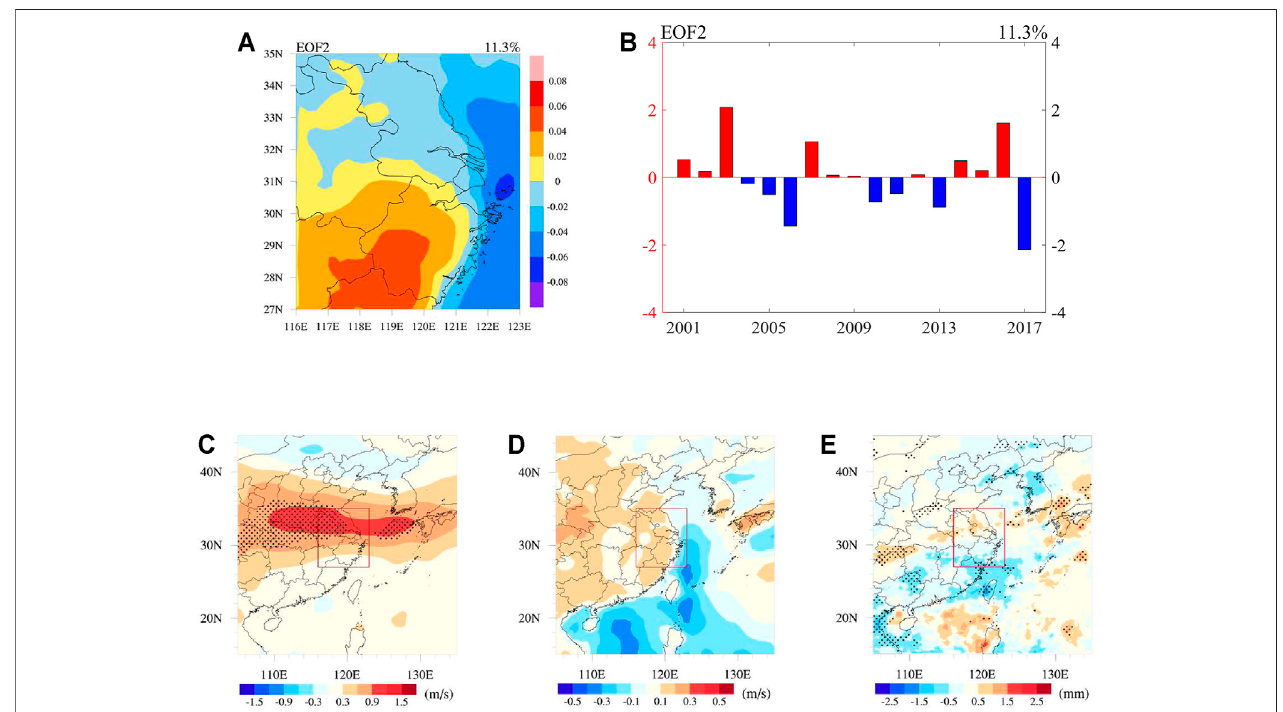
FIGURE4| TheresultsforthesecondEOF(EOF2),including (A) thespatialpatternofEOF2, (B) thetimeseriesofEOF2(histogram),andtheregressioncoef fi cients between time series of EOF2 and (C) 500 hPa wind speed, (D) 10 m wind speed, and (E) precipitation. In (B) , the indexes are normalized. In (C) to (E) , the spotted area passes 90% of the signi fi cance test, and the red rectangular region indicates the